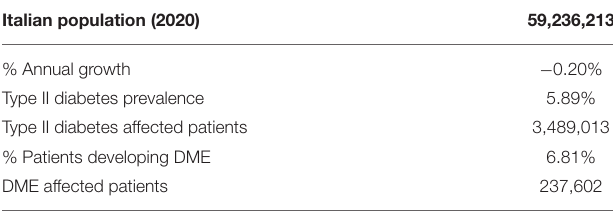
TABLE 1 | Target population. TABLE 2 | Treatment administration schemes, follow-up and interventions for the